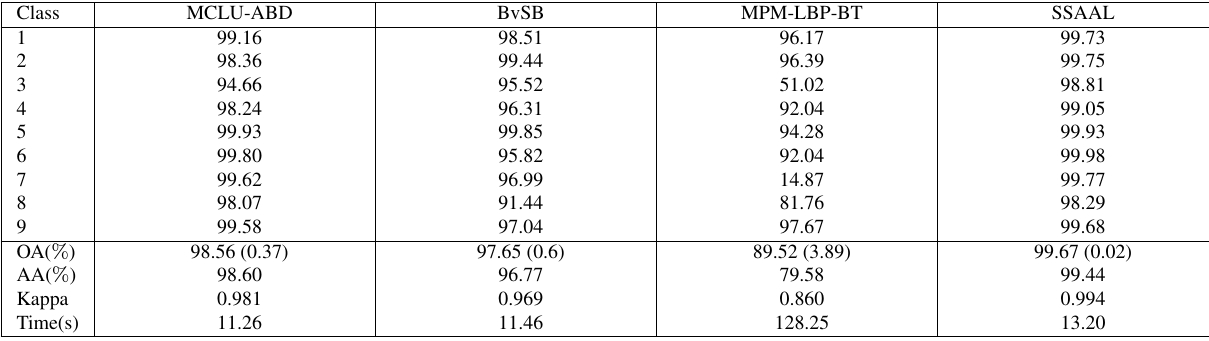
Figure 7. Classification maps obtained by different AL techniques on KSC dataset.